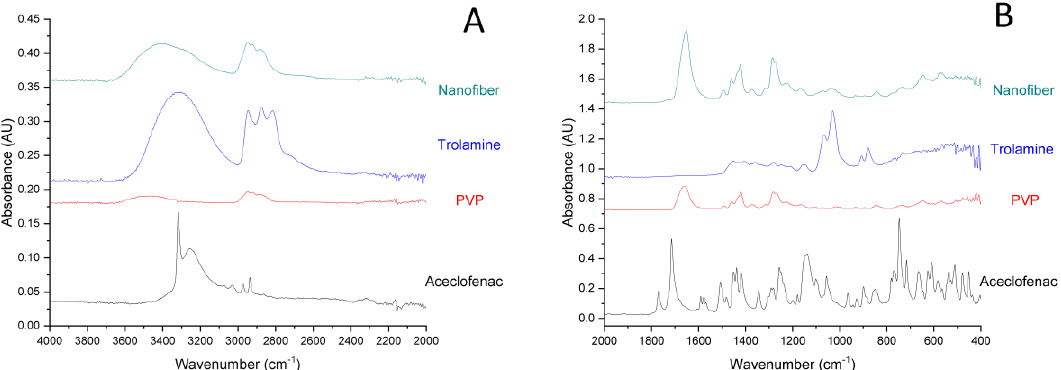
Figure 3. Expanded FT-IR spectra ( A ) 4000 – 2000 cm −1 ; ( B ) 2000 – 400 cm −1 ) of individual components and the nanofibrous formulation (composition N2: 10 mg/g aceclofenac, 15 w / w % PVP, 1 w / w % trolamine in ethanol:water 75:25 w / w %).